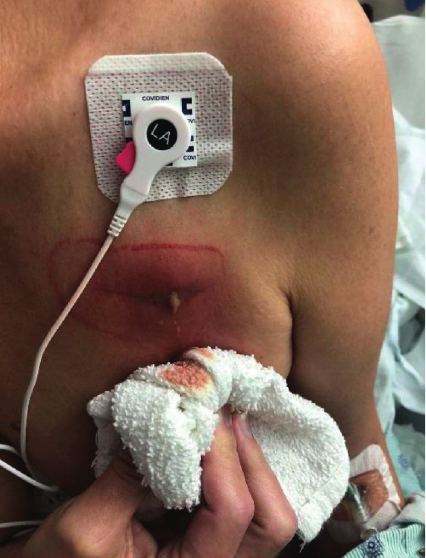
Figure 2: Pacemaker pocket site with purulence expression from the surgical scar.